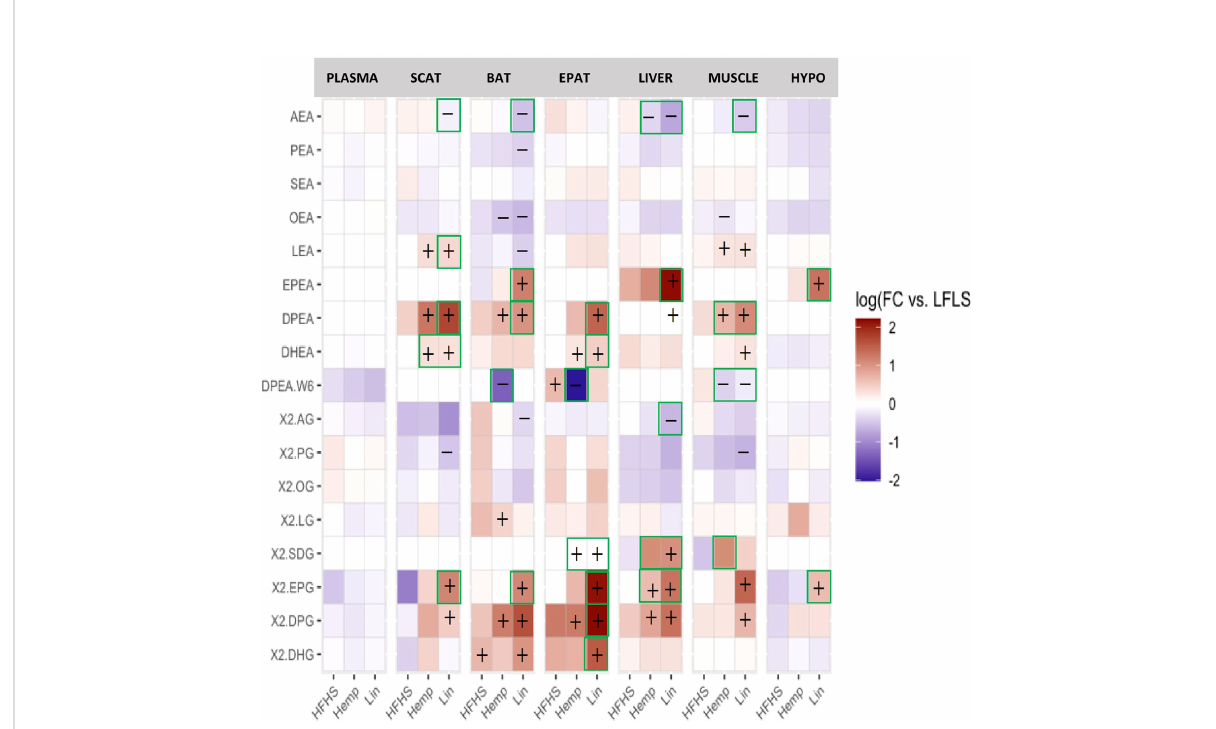
FIGURE 5 eCBome bioactive lipid mediator levels in plasma, brown adipose tissue (BAT), epididymal adipose tissue (EPAT), subcutaneous adipose tissue (SCAT), hypothalamus (HYPO), liver, and muscle. Statistically signi fi cant differences between the high-fat high sucrose groups (HFHS, Hemp, or Lin) versus the LFLS group are indicated with a “ + ” (increase in expression) or “ − ” (decrease in expression); p < 0.05. Green boxes indicate signi fi cant differences between Hemp or Lin and HFHS; p <